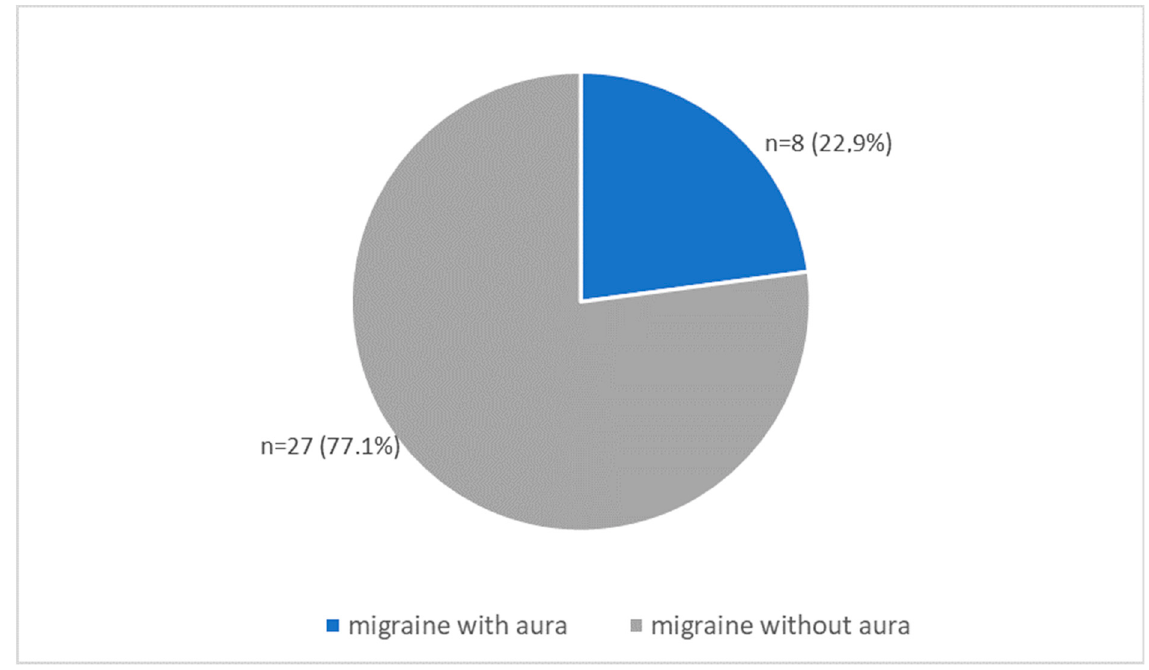
Figure 1. Characteristics of the type of migraine in the study group ( n =